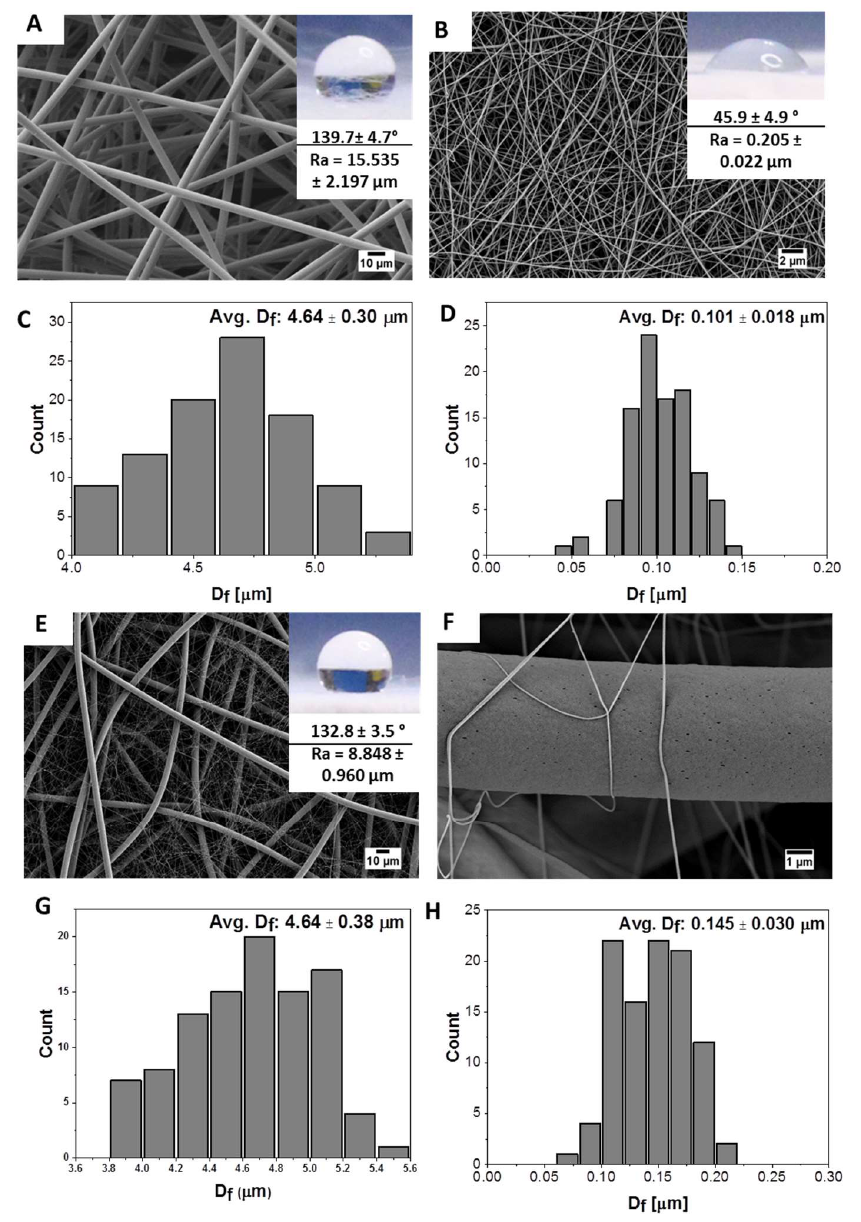
Figure 2. SEM micrographs of electrospun fibers of ( A ) PS, ( B ) PA6, ( E ) PS-PA6 composites, and ( F ) PS-PA6 composite with the higher magnification showing a few PA6 nanofibers on the individual PS microfiber. The fiber diameter distribution showed in histograms for ( C ) -PS; ( D ) -PA6, ( G ) -PS in the composite, and ( H ) -PA6 in the composite